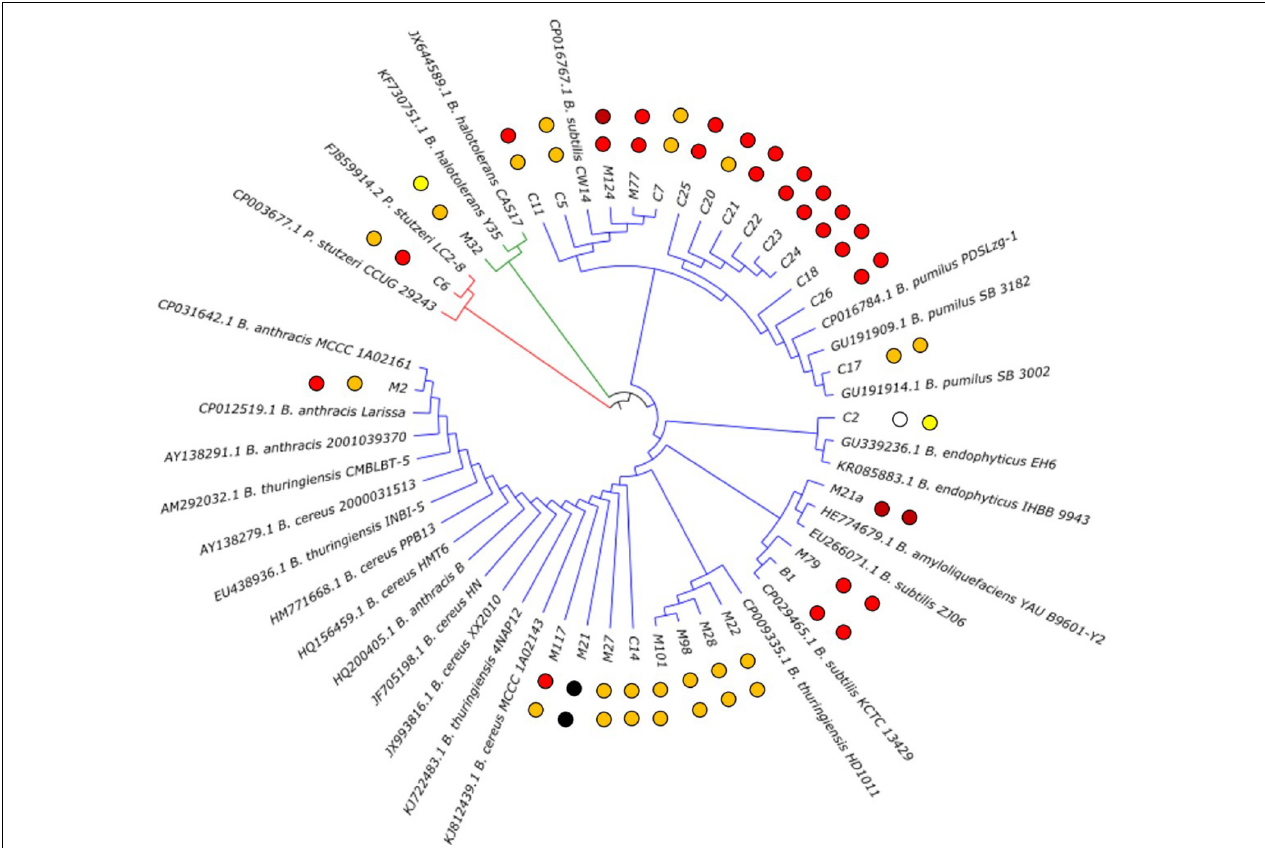
FIGURE 2 | Phylogenetic tree of the isolated bioactive bacteria. The two closest homologoues based on 16 rDNA analysis for each isolate are given. The isolates from this study are carrying their identifier (compare Table 1 ). The observed antibacterial activity against E. coli ATCC25922 (inner dots) and S. aureus ATCC 29213 (outer dots) is indicated by dark red (strong activity), red (good activity), orange (moderate activity) and yellow (weak activity) dots. Strain M21 lost its viability during the project; therefore, the values could not be determined.